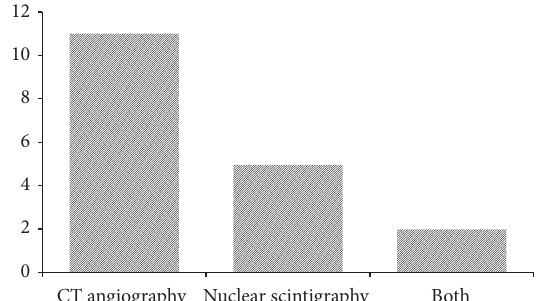
Figure 2: Diagnostic imaging modality performed.